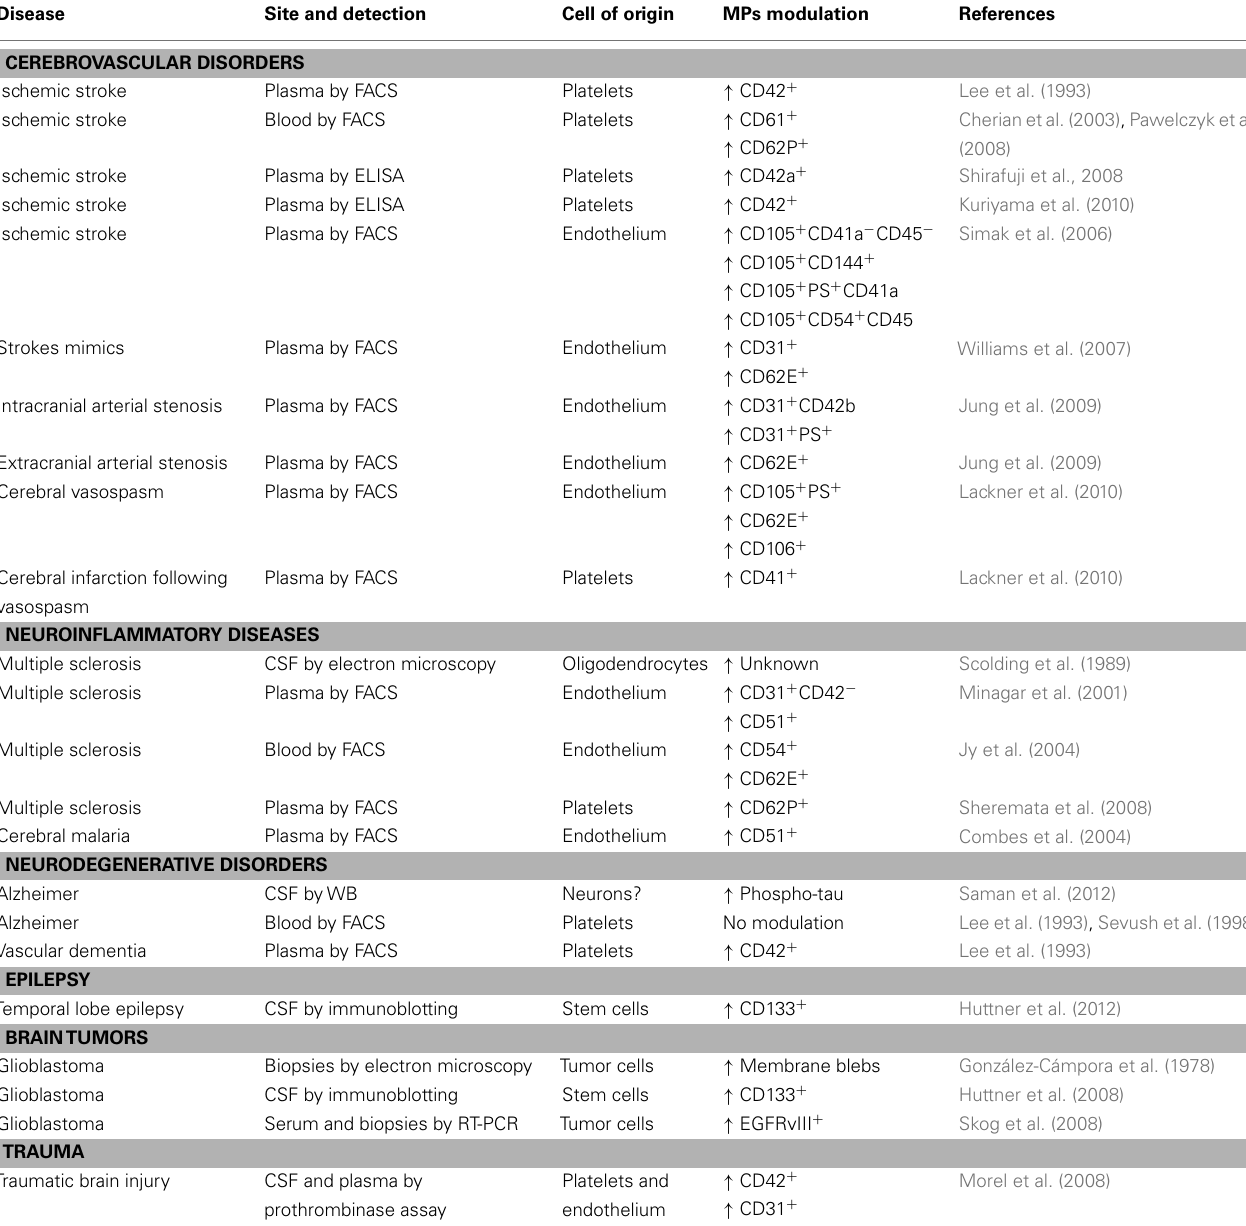
Table 1 | MVs in neurological